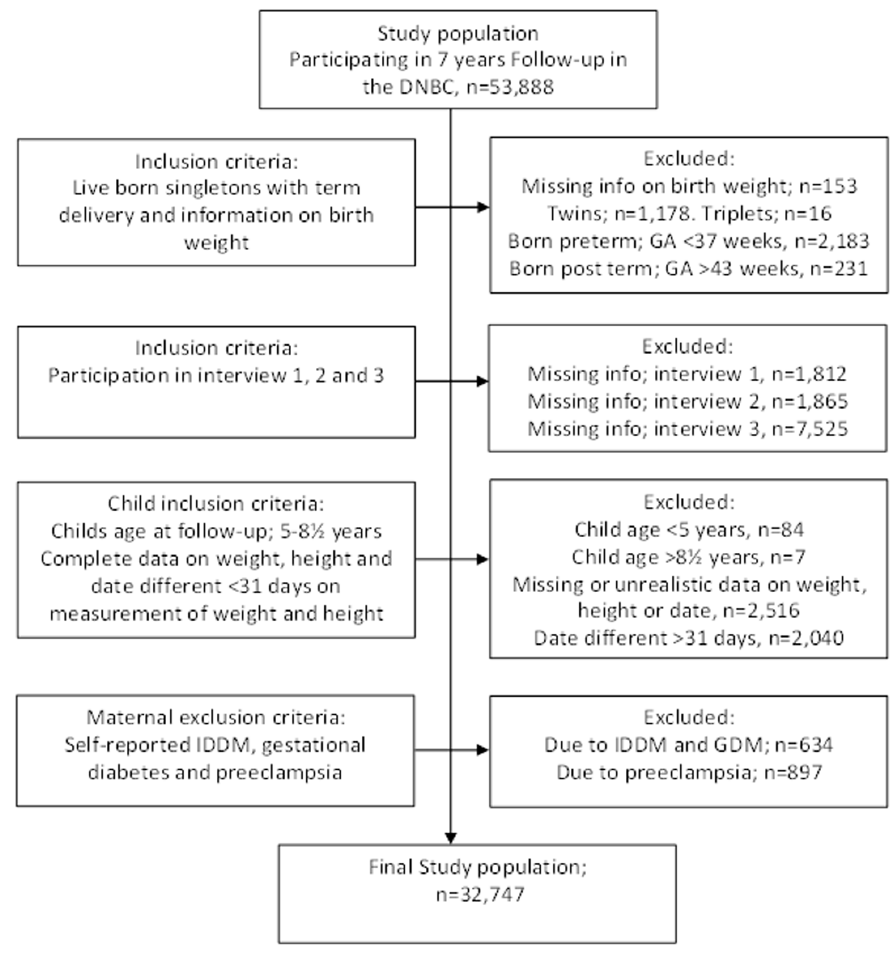
Figure 1. The figure show a flow chart of the study population.